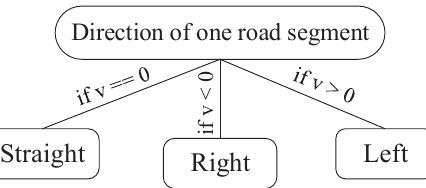
Figure 6. Direction of one road segment. Note that, v is the difference value in direction of two adjacent road segments obtained in Formula (3).